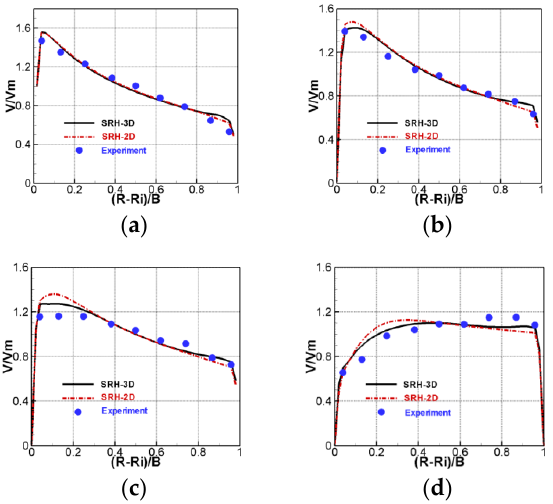
Figure 6. Comparison of simulated depth-averaged velocity (normalized by the average velocity) across the channel width at four transects for the bend case. ( a ) 35°; ( b ) 100°; ( c ) 143°; ( d ) 186°.